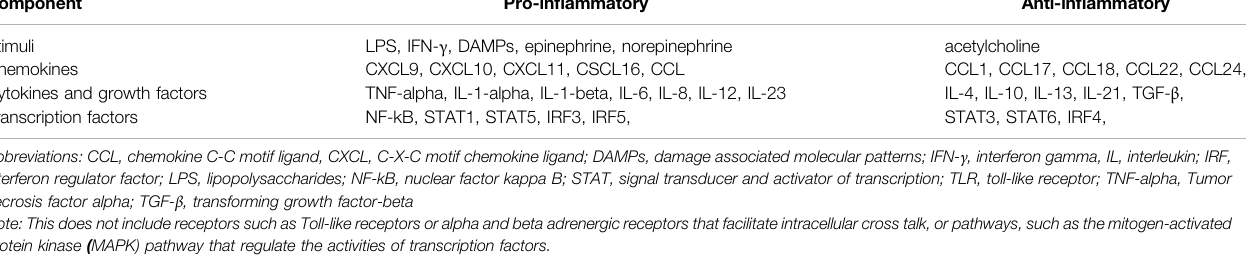
TABLE 2 | Components and examples of signalling molecules involved in intracellular crosstalk.